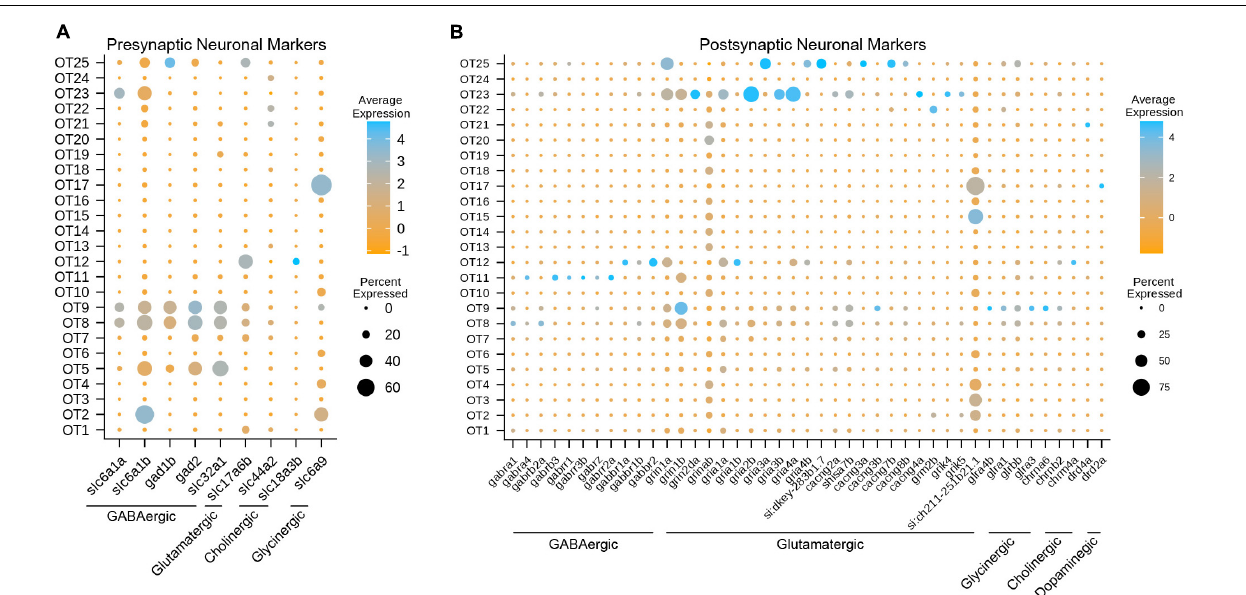
FIGURE 4 | Gene expression profiles characterize the neuronal profiles of OT cells. (A) Select presynaptic markers identify mature inhibitory (GABAergic, glycinergic, cholinergic) and excitatory (glutamatergic) tectal populations. (B) Select postsynaptic markers identify the potential synaptic partners of tectal neurons by exploring genes required for various neurotransmitter receptors. All markers were manually curated based on functional designation on the ZFIN database (https://zfin.org/); see Supplementary Table 7 for all pre- and postsynaptic markers.